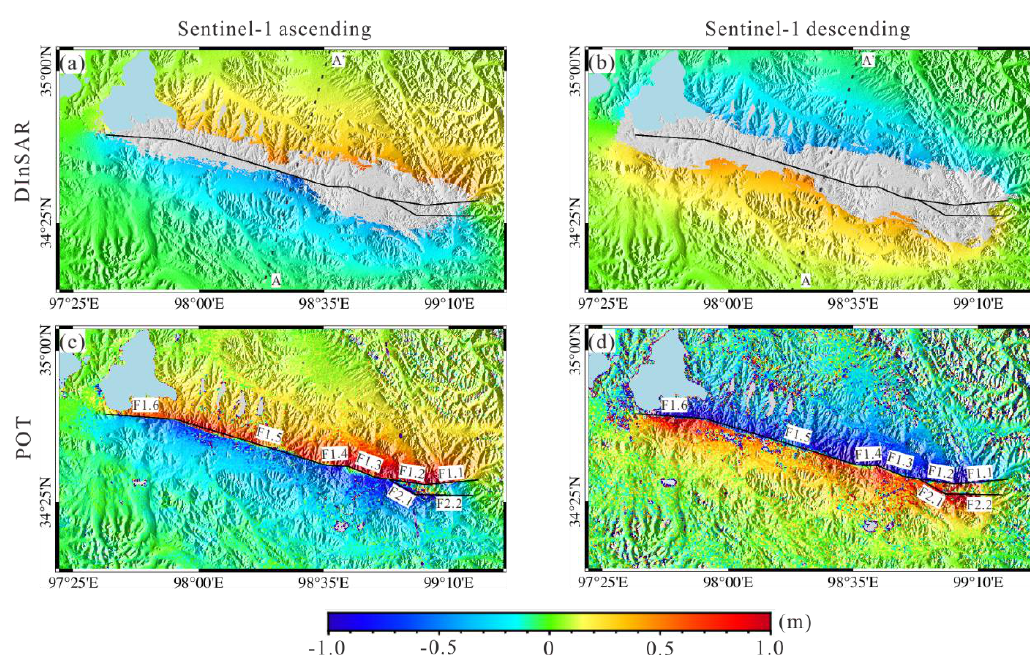
Figure 2 . Across-track displacements of the 2021 Maduo earthquake derived from Sentinel-1 TOPS data, utilizing DInSAR for ascending (a) and descending (b) tracks and range offsets derived from ascending (c) and descending (d) tracks. The black solid lines, marked by F1 and F2, indicate the two distinct fault lines extracted with the POT technique. The black dashed line is the AA′ profile, which is used to analyze the across-track displacements in Section 2.4.